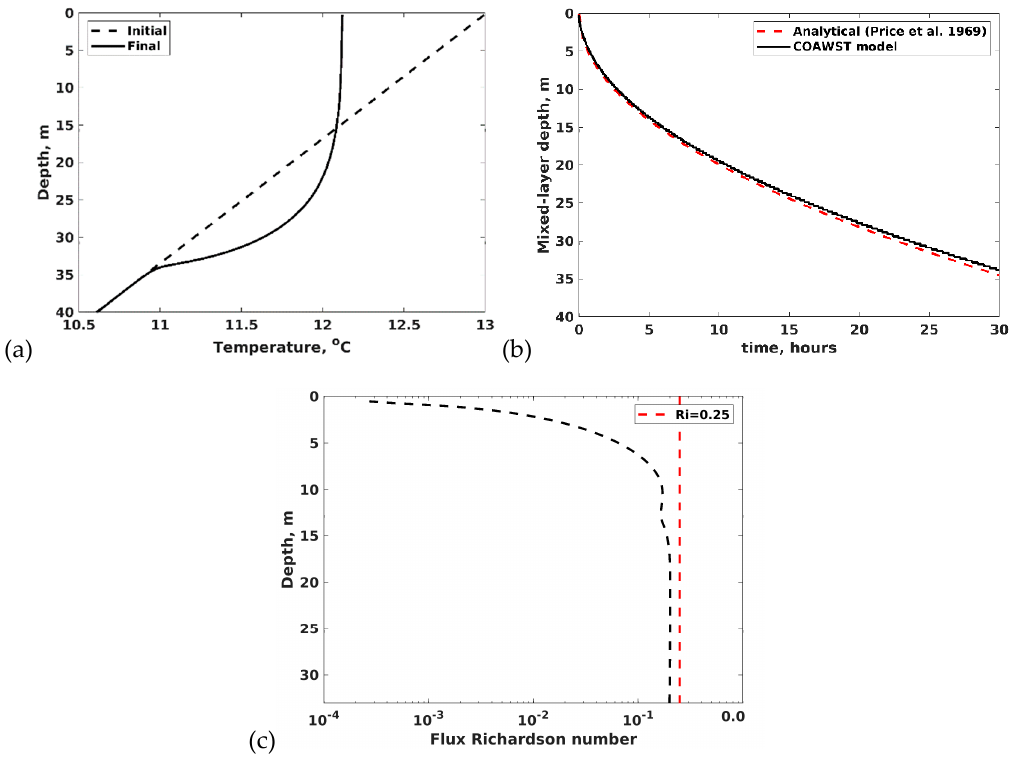
Figure 1. Test case 1: Wind induced mixed-layer deepening; Vertical profiles ( a ) initial and final temperature, ( b ) Comparison of model output with analytical solution of Price et al. (1979), and ( c ) Flux Richardson number ( R f ) at the end of simulation.